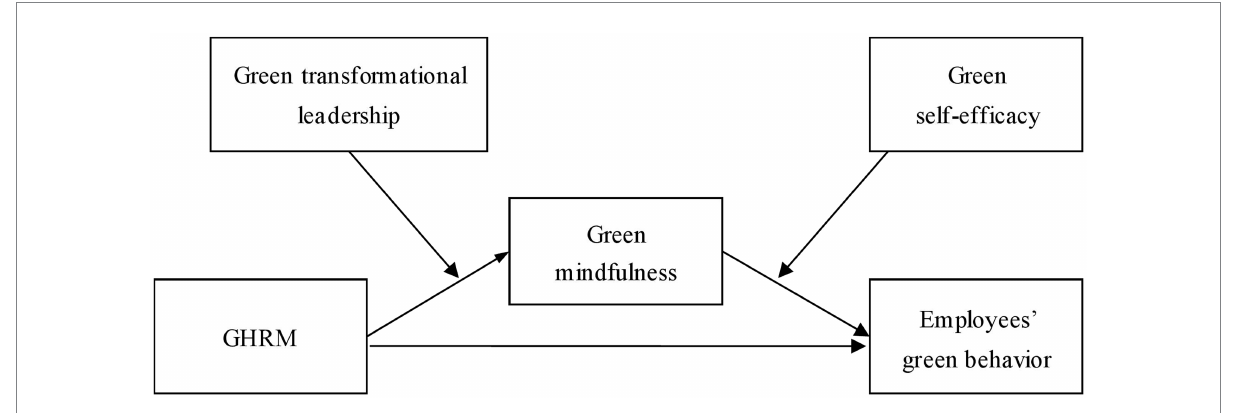
FIGURE 1 The theoretical model of the green behavior of Chinese employees.